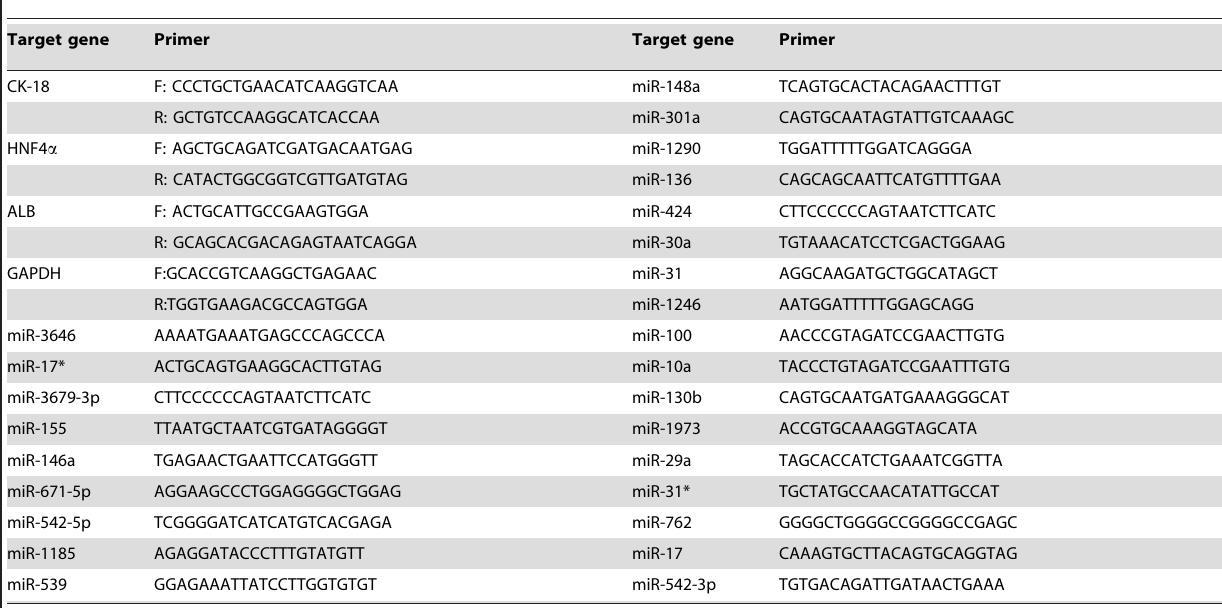
Table 1. Primers for target genes for qRT-PCR